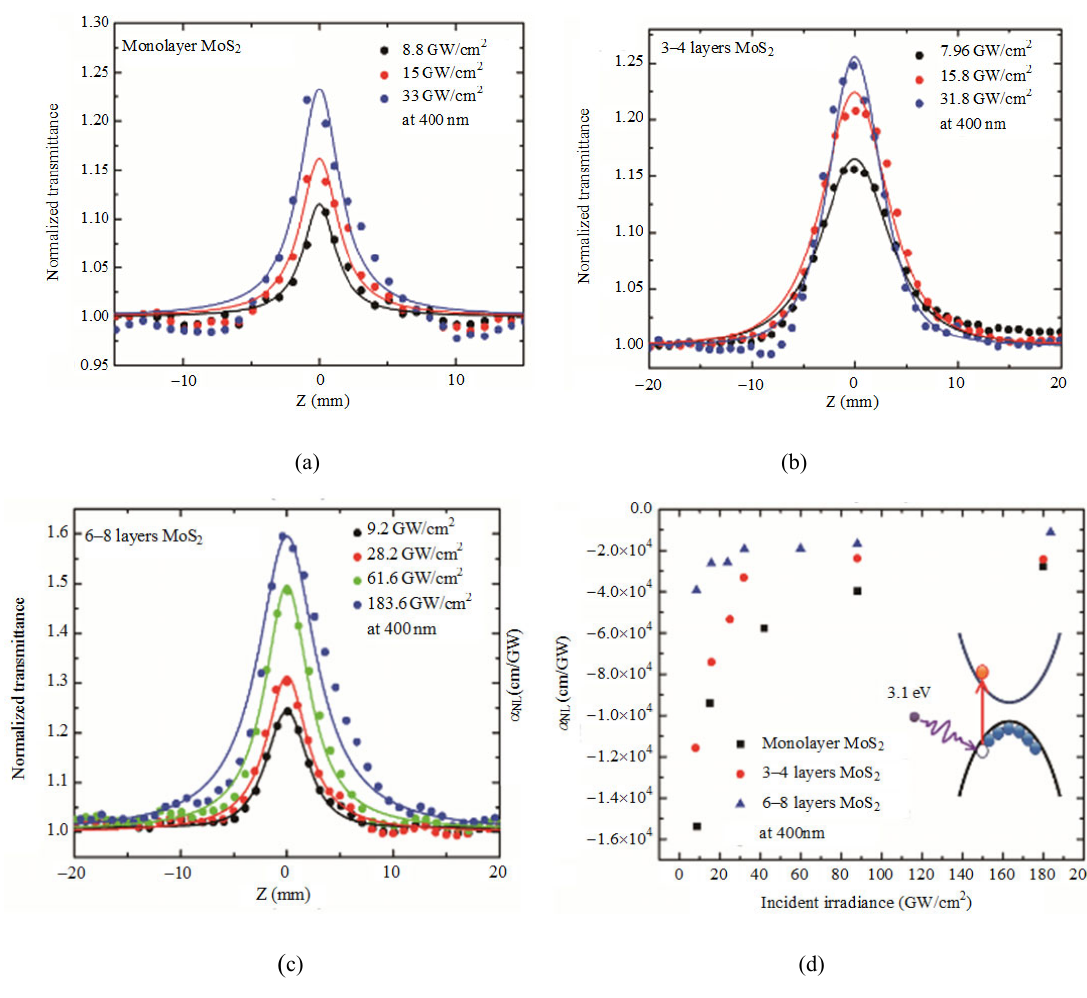
Fig. 2 OA Z-scan results of (a) monolayer, (b) 3 ‒ 4 layers, and (c) 6 ‒ 8 layers MoS 2 . The dots are experimental data, and solid lines show theoretical fit generated by the theory of Z-scan, and (d) NLO absorption coefficients for three MoS 2 . Inset: schematic of the SA process. In these measurements, a 400-nm excitation laser (65 fs) is